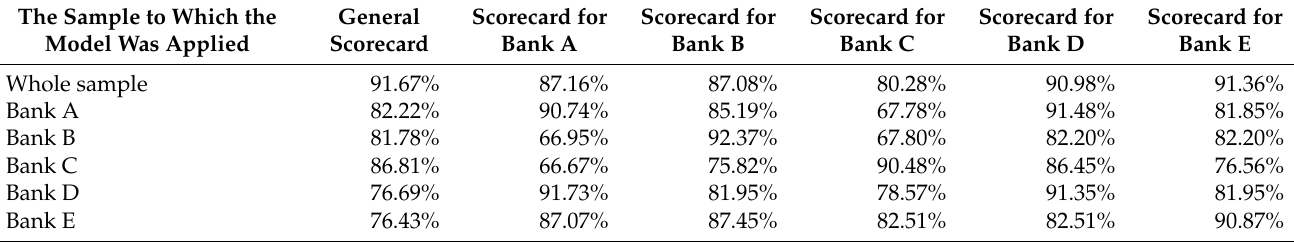
Table 13. Summary of the overall efficiency level of the developed scoring models to evaluate customers in other banks. The Sample to Which